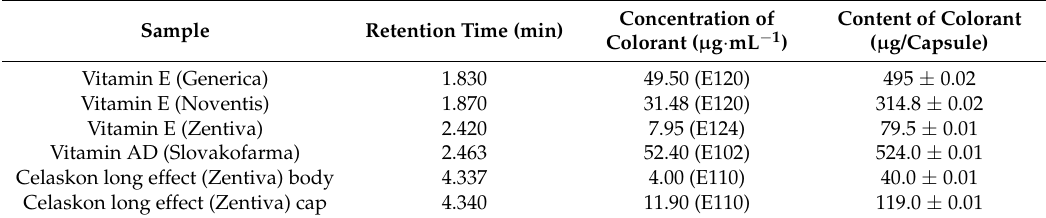
Table 1. Retention time of studied samples; the content of dyes in the vitamin samples.